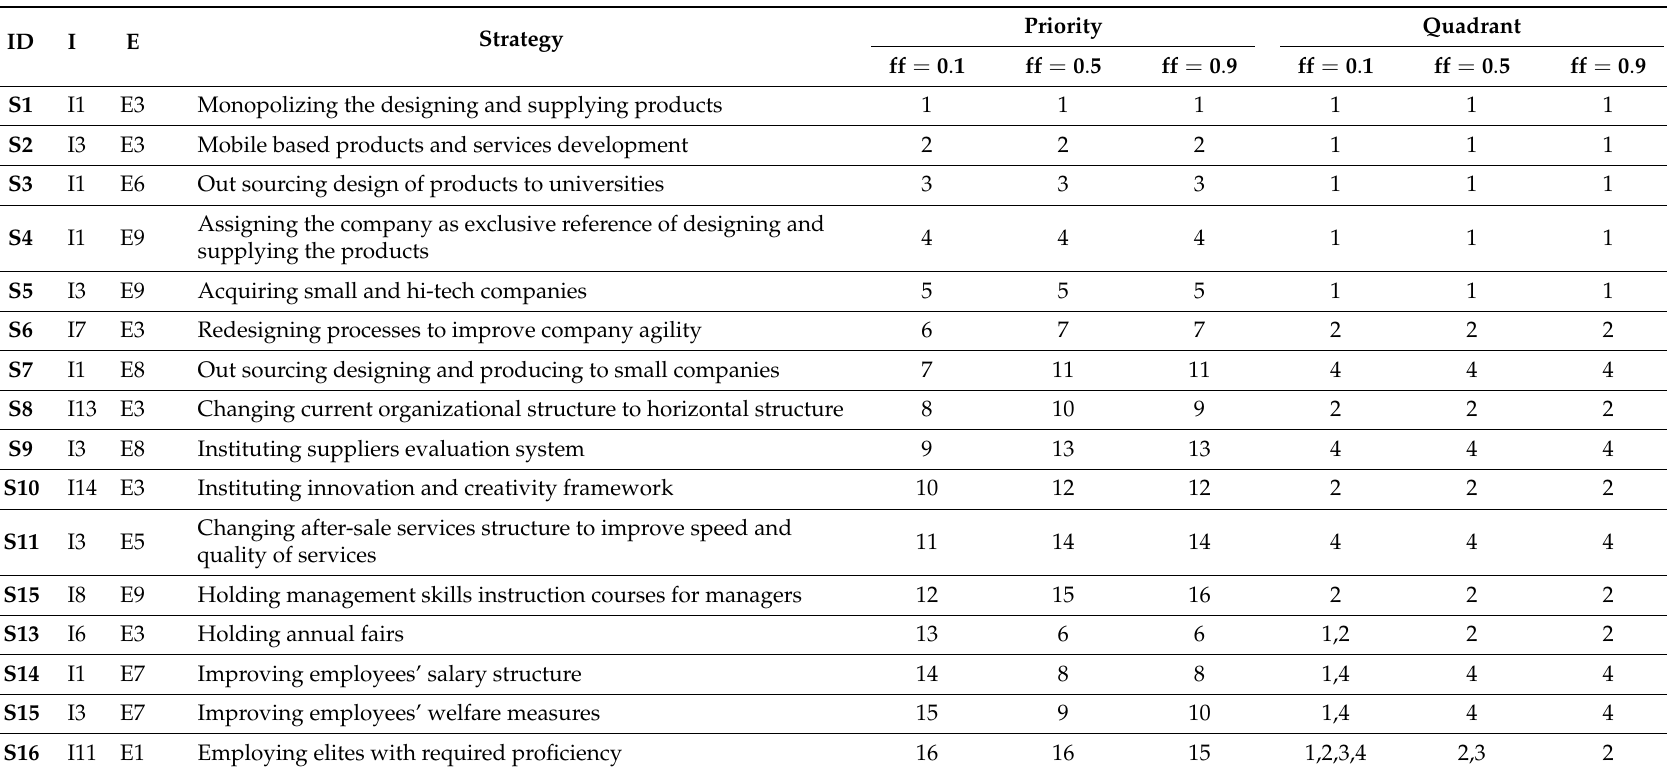
Table 5. Extracted strategies, their priority, α values, and